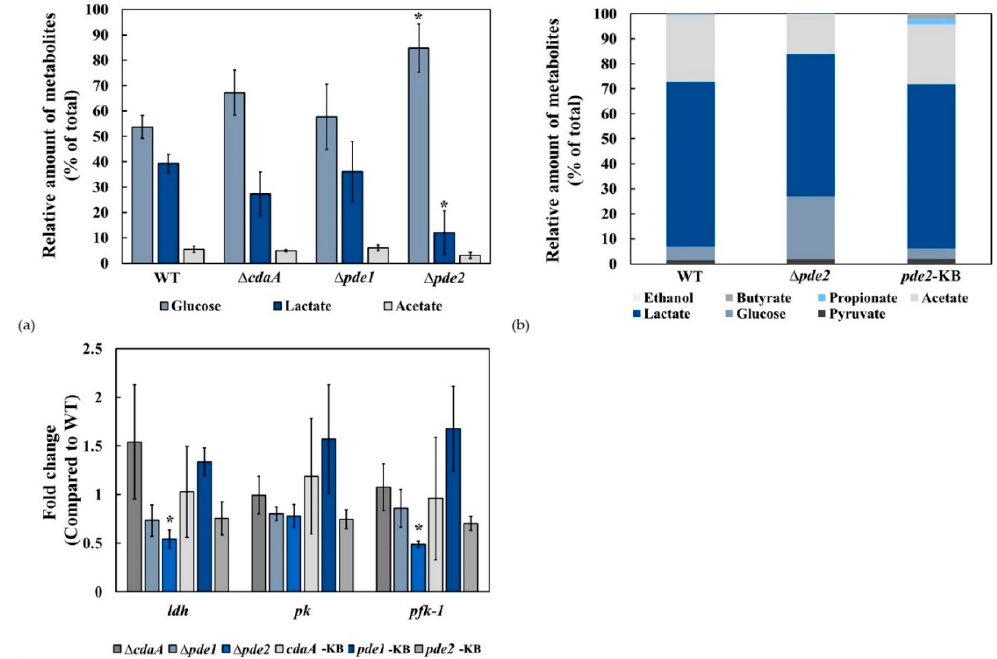
Figure 7. Metabolism of glucose is slower in the ∆ pde2 -mutant. ( a ) The relative concentration of 14 C-labelled glucose and the major metabolites lactate and acetate was determined for the WT, ∆ cdaA -, ∆ pde1 -, and ∆ pde2 -mutants. * Students t-test p < 0.05. ( b ) The reduced glucose metabolism of the ∆ pde2 mutant was restored in the pde2 -KB strain. The levels of glucose and lactate was significantly di ff erent ( p < 0.05) in the ∆ pde2 -mutant compared to WT ( c ) Transcription of genes related to glucose metabolism were investigated by RT-qPCR. Total RNA was extracted from liquid cultures, cDNA was synthesized and qPCR was performed with primers for phosphofructokinase-1( pfk-1 ), lactate dehydrogenase ( ldh ), pyruvate kinase ( pk ) and gyrA as the reference gene. Data are represented as the fold change in the ∆ cdaA - ∆ pde1 -, ∆ pde2 mutants and the cdaA -KB, pde1 -KB and pde2 -KB strains compared to the WT calculated by the ∆∆ Cq-method. Shown are means and standard errors of the mean from two independent experiments. * indicates statistical significance ( p <